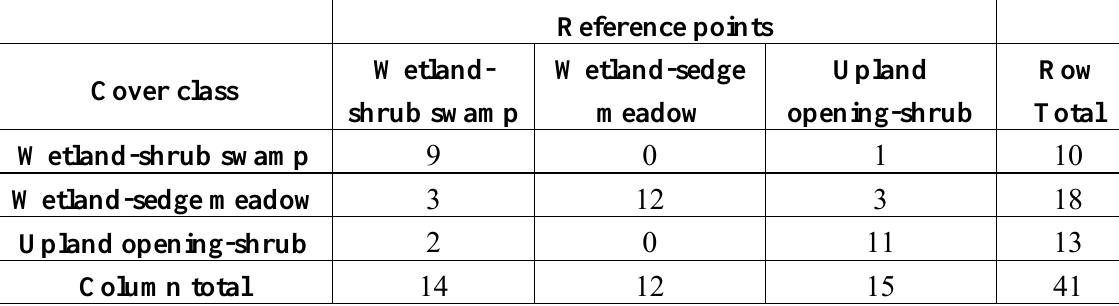
Table 3A. The error matrix of the corrected image (image 1) for Nicolet (northern Wisconsin, scene ID #is